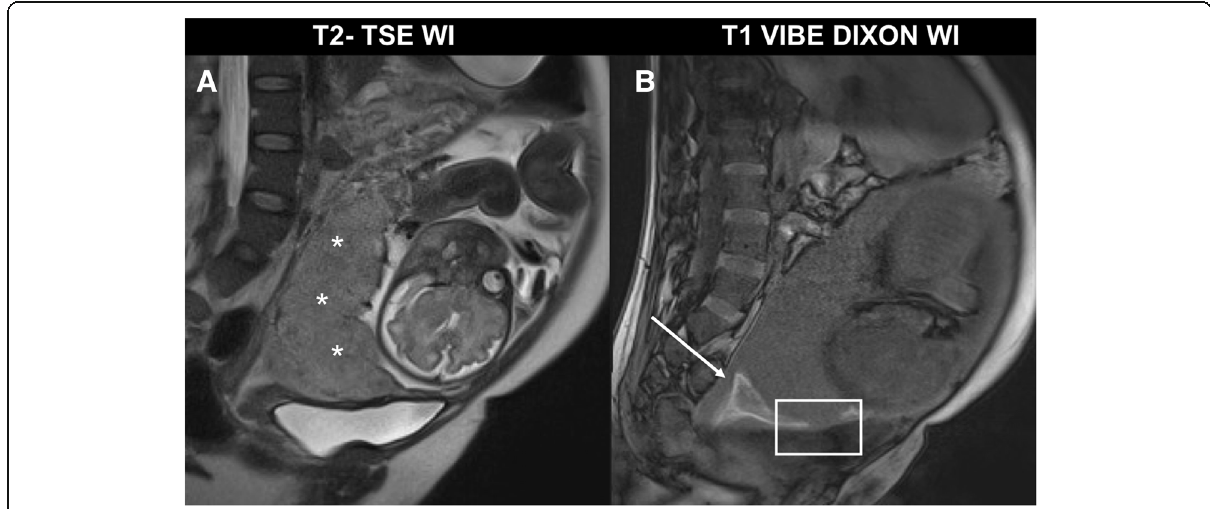
Fig. 16 Morbidity adherent placenta: placenta previa (asterisk in a ), cervical hematoma (white arrow in b ) and placenta invasion into the myometrium (placenta increta, white